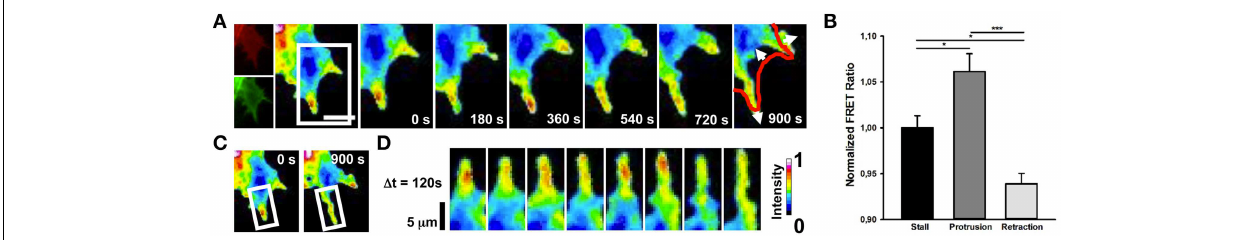
FIGURE 3 | Spontaneous Cdc42 dynamics in NG108-15 cells. (A) Ratiometric FRET live imaging of a representative Cdc42-FRET neuroblastoma cell (n = six experiments). Consecutive frames were taken every second (left: generation of a ratiometric image) for 15min. Insets on the right show a time series (1 frame every 3min) of the magnified region denoted by the white box in the left image. Arrows indicate protrusion and retraction directions. The red line shows the initial GC profile. Scale Bar: 20 µ m. (B) Quantification of mean Cdc42